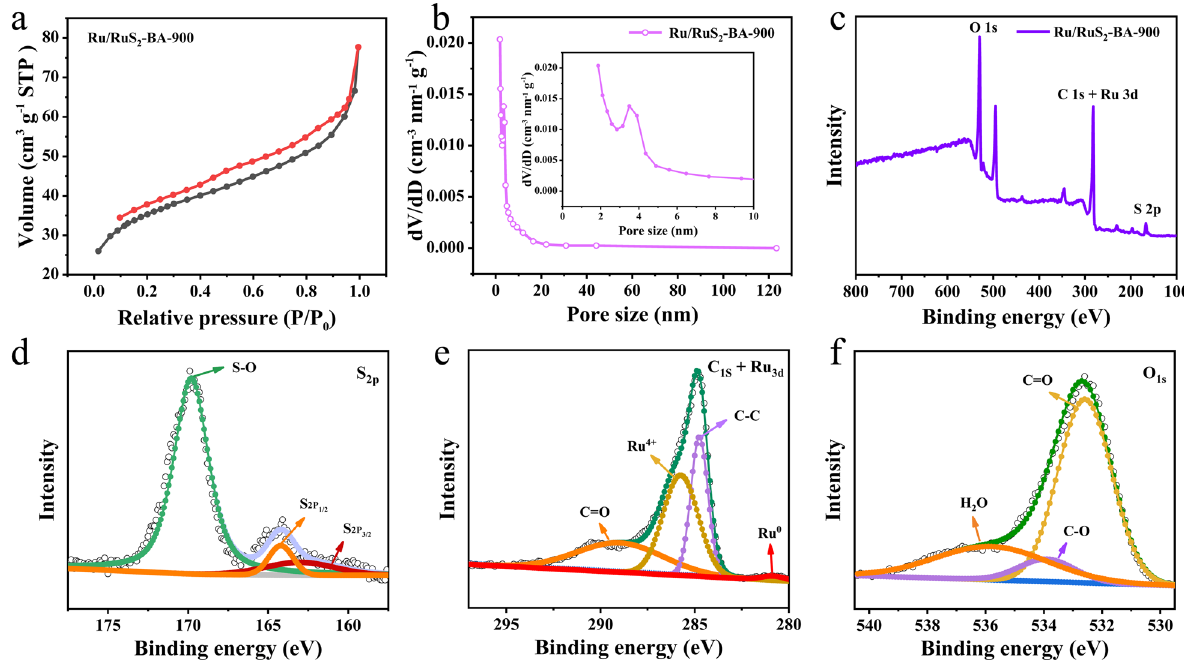
Fig. 4 a Nitrogen adsorption isotherms and b Pore size distribution of Ru/RuS sponding high-resolution XPS spectra for d S 2p , e C 1s + Ru 3d , and f O